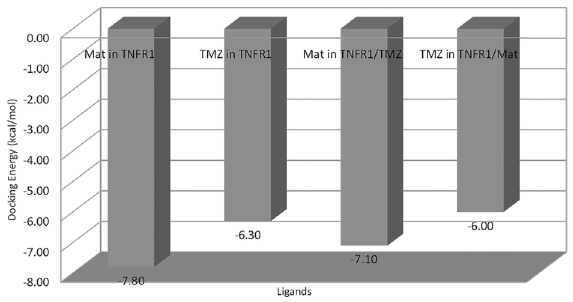
Figure 4. Docking energy for each protein/ligand complex. Mat: matteucinol; TMZ: